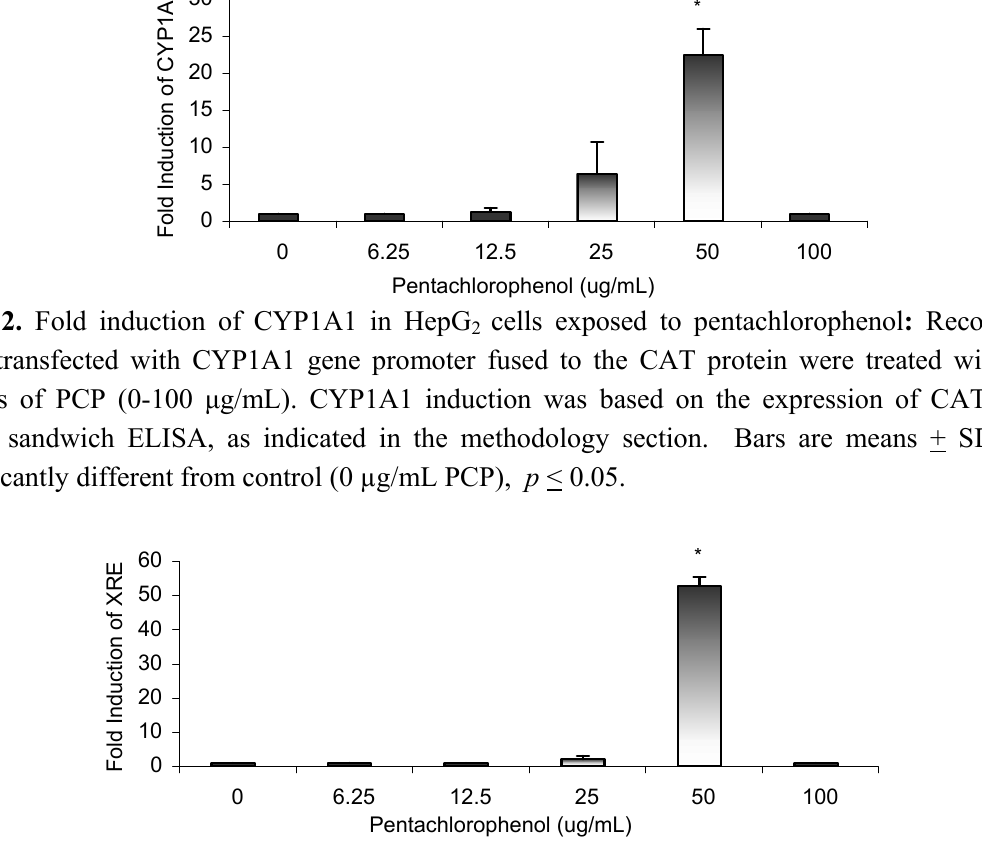
cells exposed to pentachlorophenol: Recombinant HepG 2